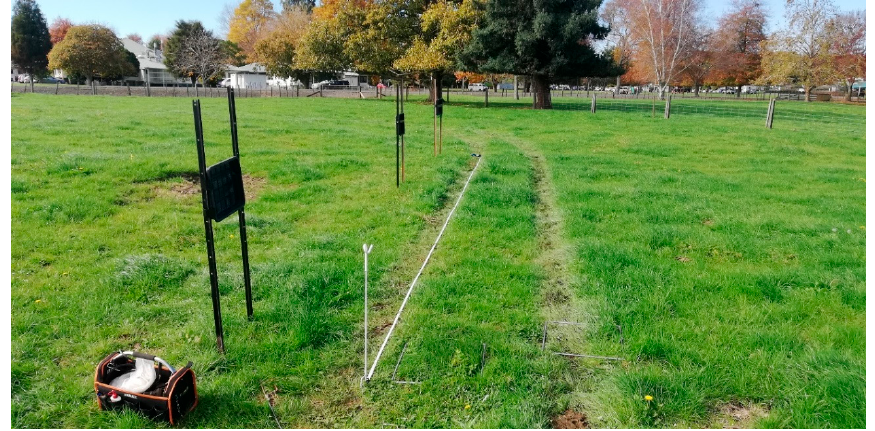
Figure 7. For Transects 2 and 3, biomass was measured every 0.5 m, starting at 0 to 0.5 m, giving 20